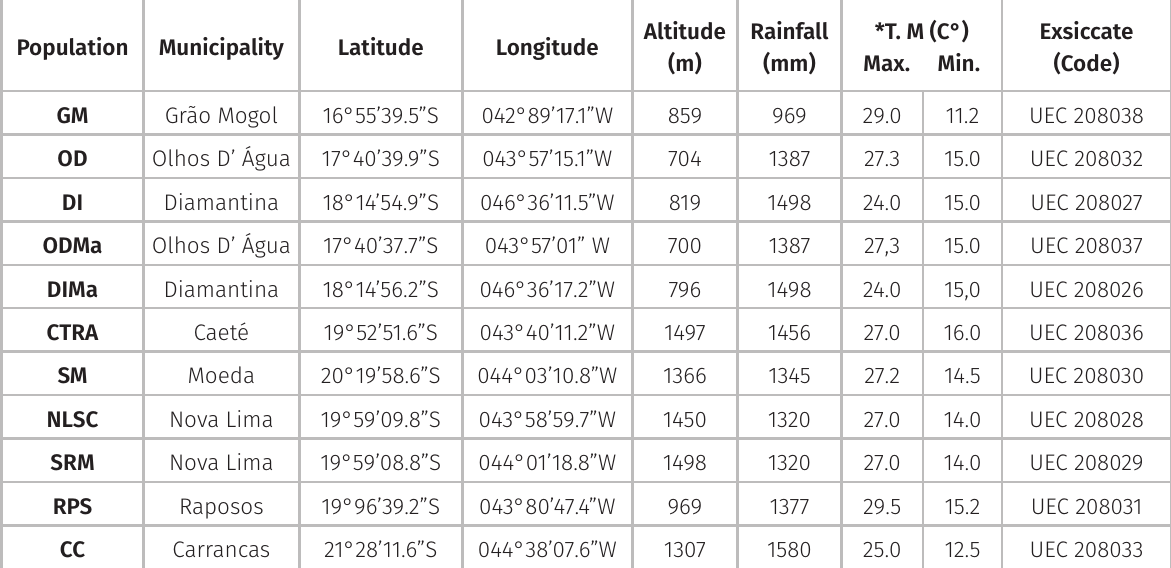
Table I. Location and characterization of regions of occurrence of natural populations of Lychnophora pinaster , State of Minas Gerais,